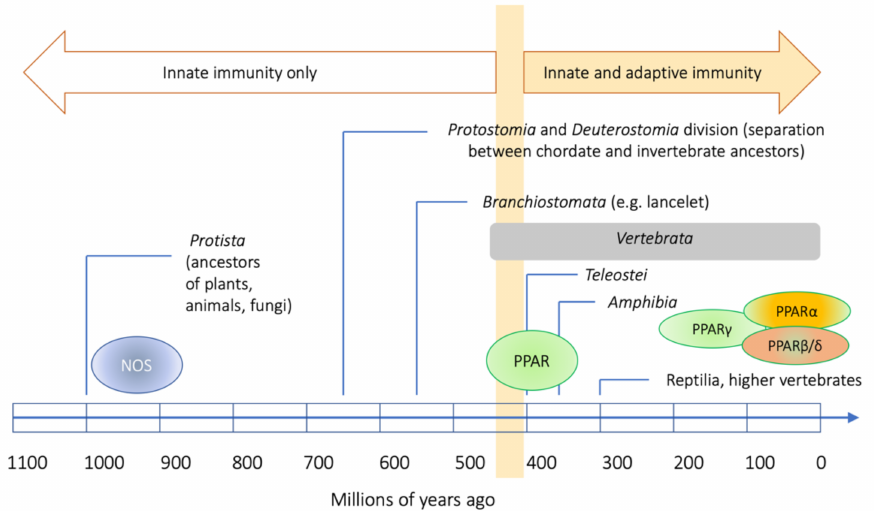
Figure 4. Long evolution of NOS as a background for shorter vertebrate-related evolution of PPARs and its involvement in the immune response in various animal phyla. The time scale is only illustrative and was based on